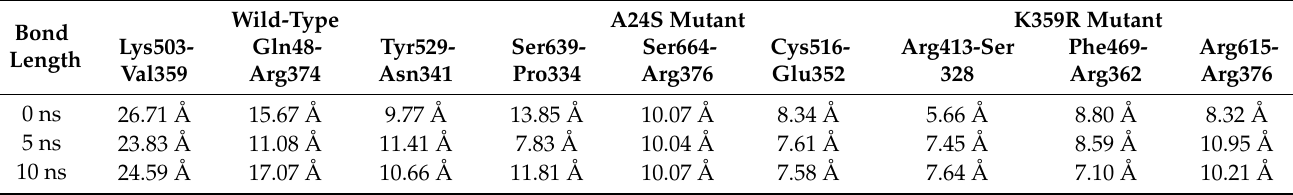
Table 6. Bond length among PKC γ variants and connexin